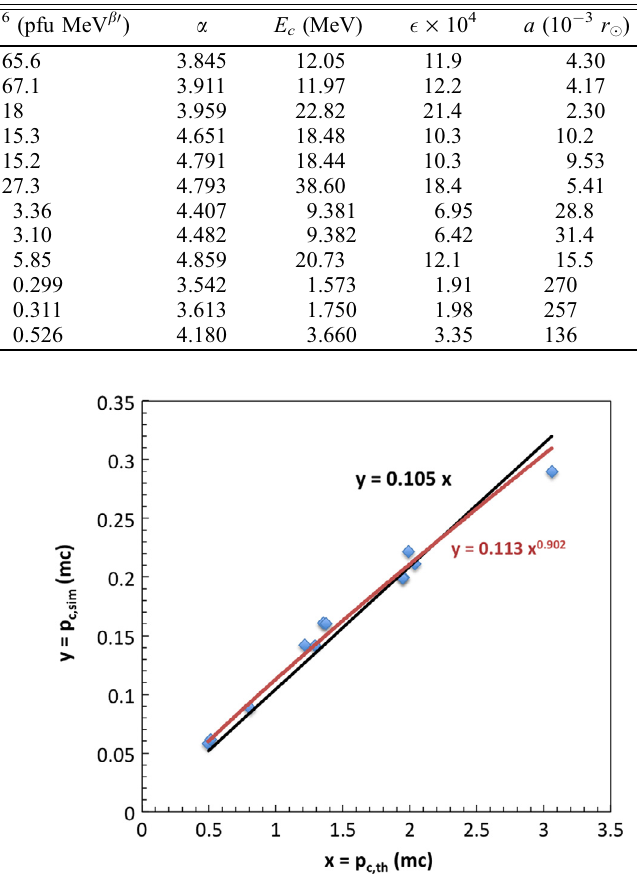
Fig. 5. Comparison of the simulated and the theoretical values of the spectral parameter p . c